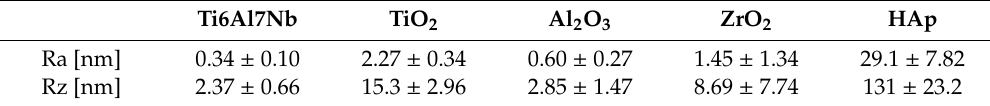
Table 2. Ra and Rz parameters of Ti6Al7Nb substrate and deposited one-component coatings.